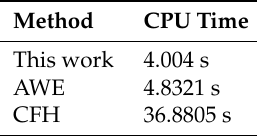
Figure 16. Comparison of discrete sweep of this work with fast sweeps of AWE [2] and CFH [8]. Table 5. Comparison of fast frequency